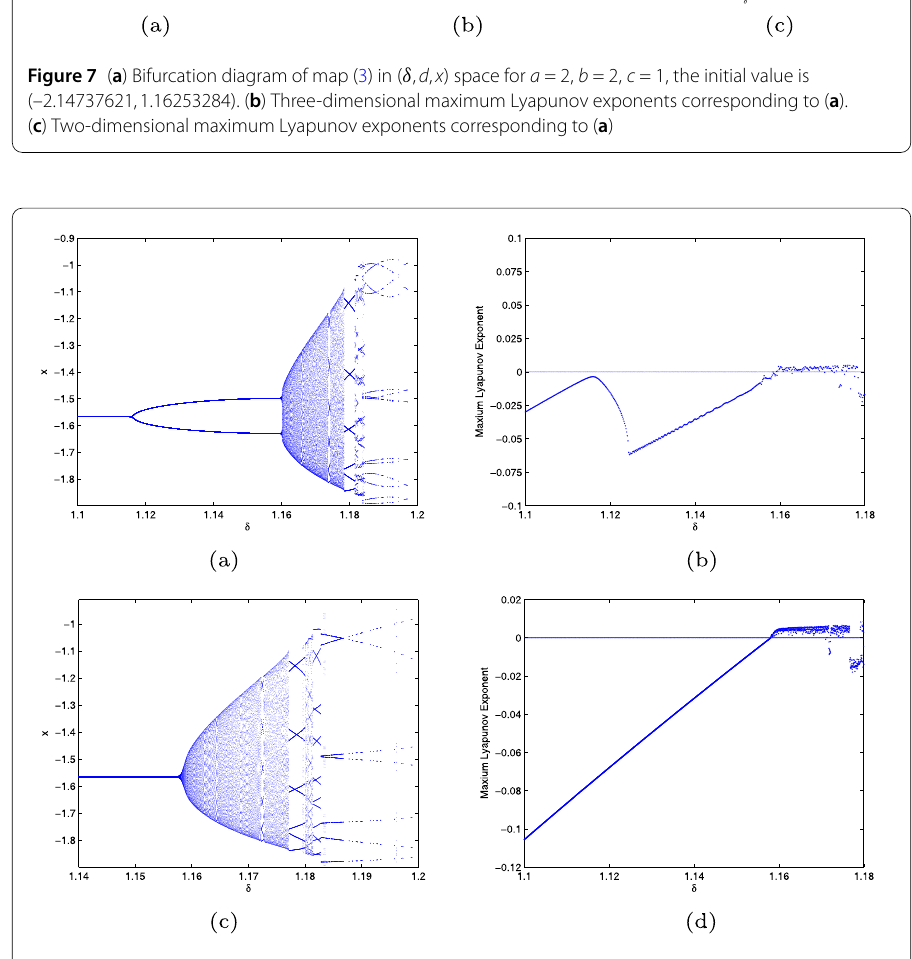
Figure 8 ( a ) Bifurcation diagram of map (3) in ( δ , x ) plane for a = 2, b = 2, c = 1, d = 3.204, the initial value is (–2.14737621,1.16253284). ( b ) Maximum Lyapunov exponents corresponding to ( a ). ( c ) Bifurcation diagram of map (3) in ( δ , x ) plane for a = 2, b = 3, c = 0.8, d = 3.208. The initial value is (–2.14737621,1.16253284). ( d ) Maximum Lyapunov exponents corresponding to ( c